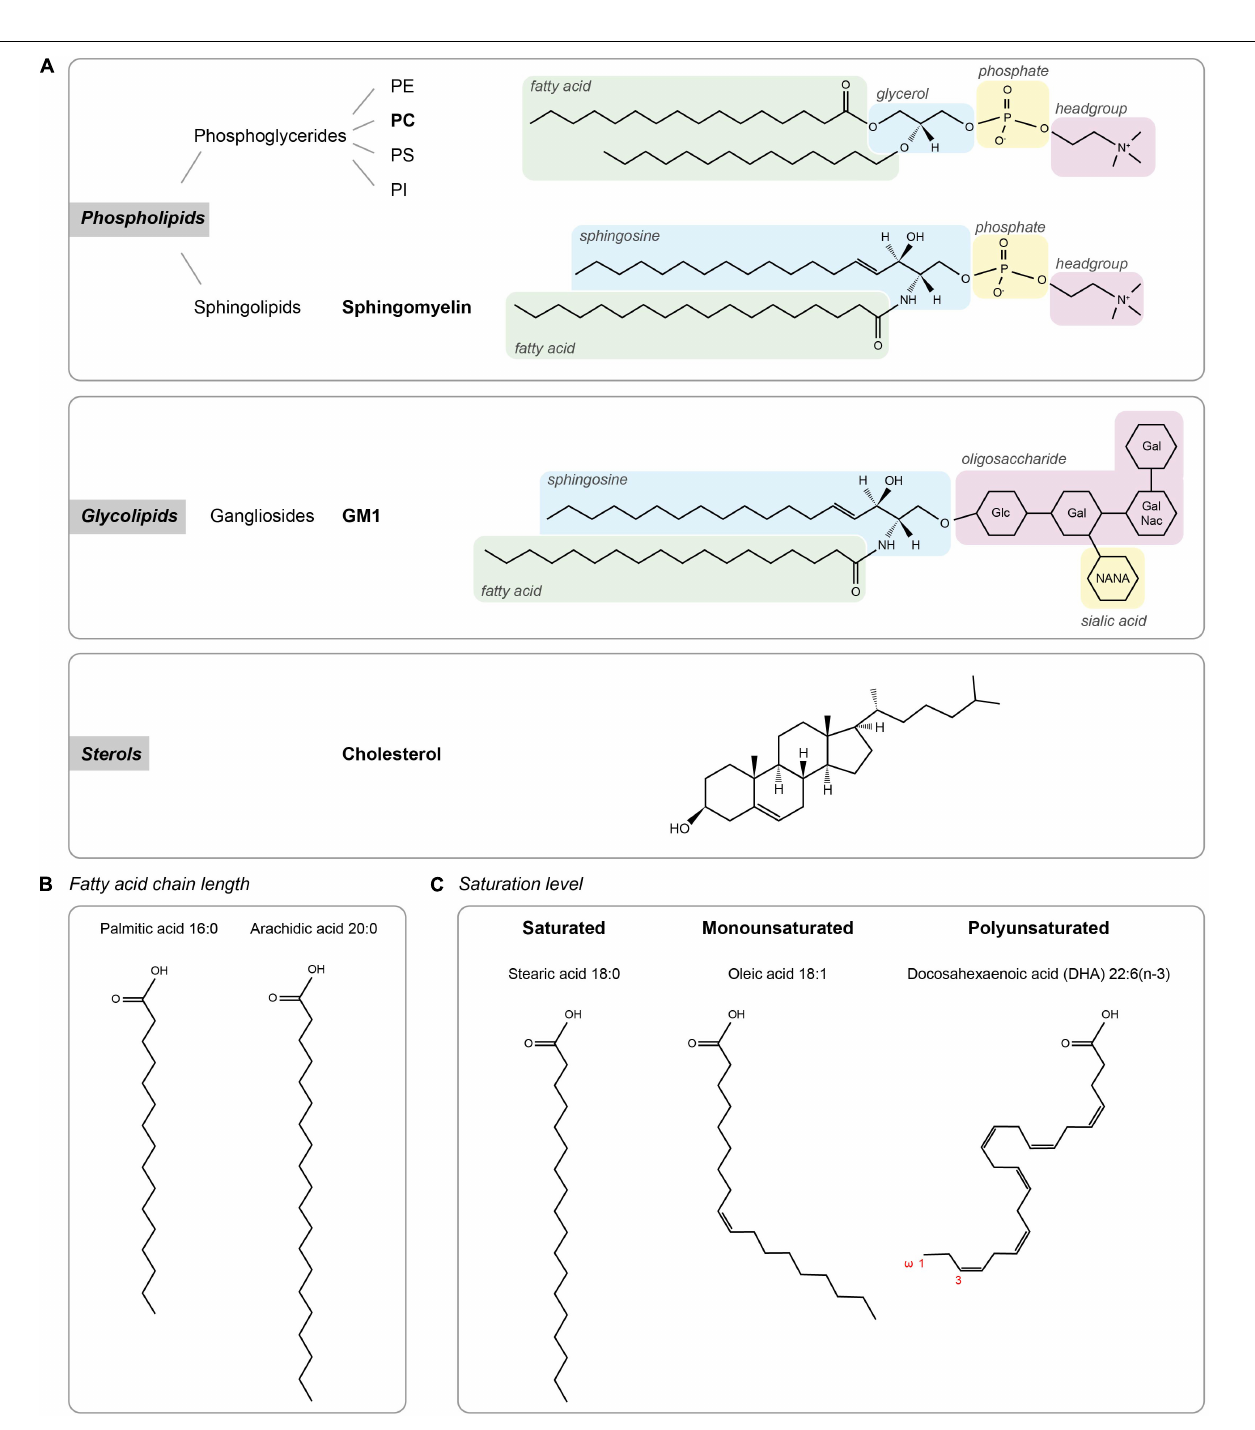
Frontiers in Synaptic Neuroscience |